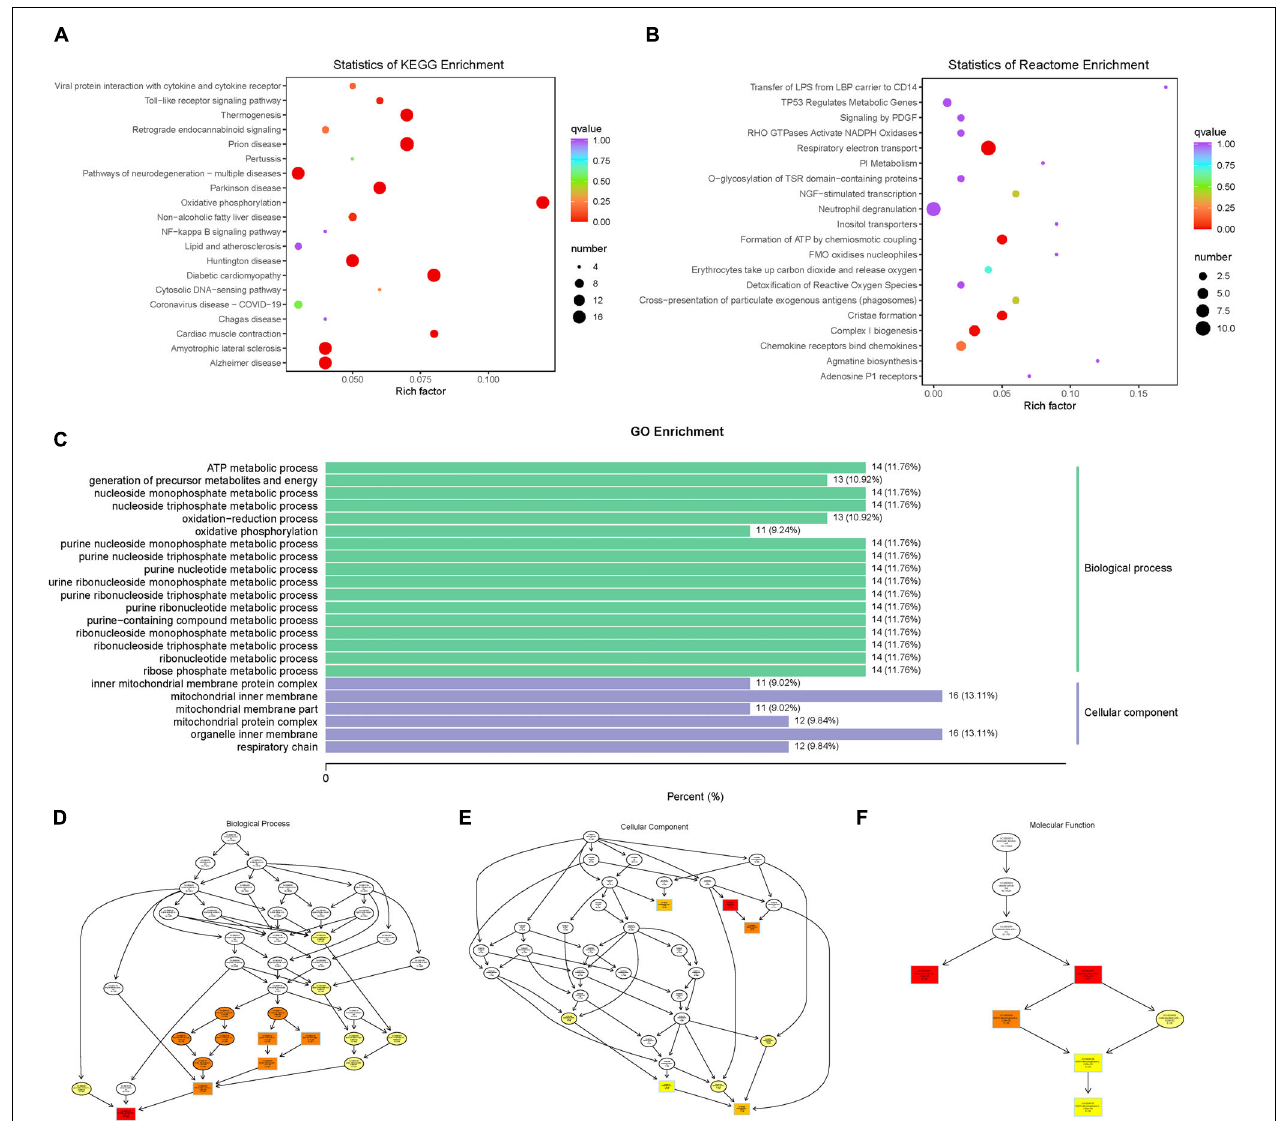
FIGURE 9 | (A) scatter plot of KEGG enrichment analysis. (B) scatter plot of Reactome enrichment analysis. (C) histogram of GO enrichment analysis. (D) topGO directed acyclic graph of a biological process. (E) topGO directed acyclic graph of the cellular component. (F) topGO directed acyclic graph of molecular